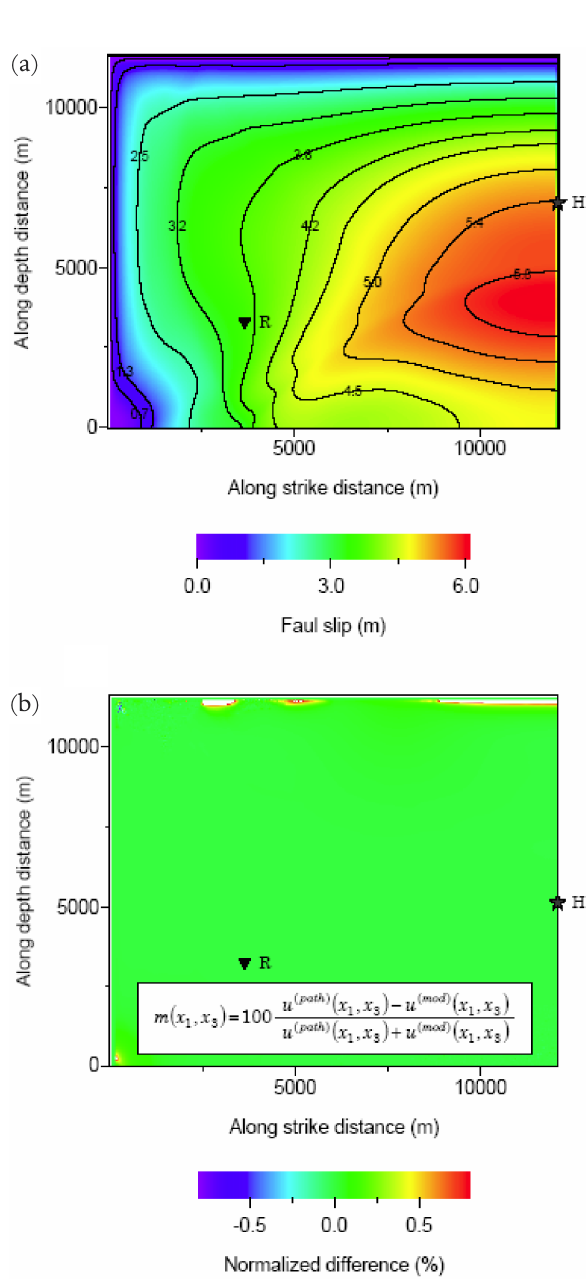
Figure 2. (a) Distribution of the fault slip at time t = 4.2 s for a fault with homogeneous properties (the parameters are listed in Table 1) and in the case of the formulation (1). (b) Corresponding normalized difference between formulation (1) and formulation (2). In each fault , x ) we plot the misfit (*). The locations of the hypocenter node ( x 1 3 (H) and of the fault received (R) are also indicated. Note that due to the symmetry of the problem only one half of the fault is